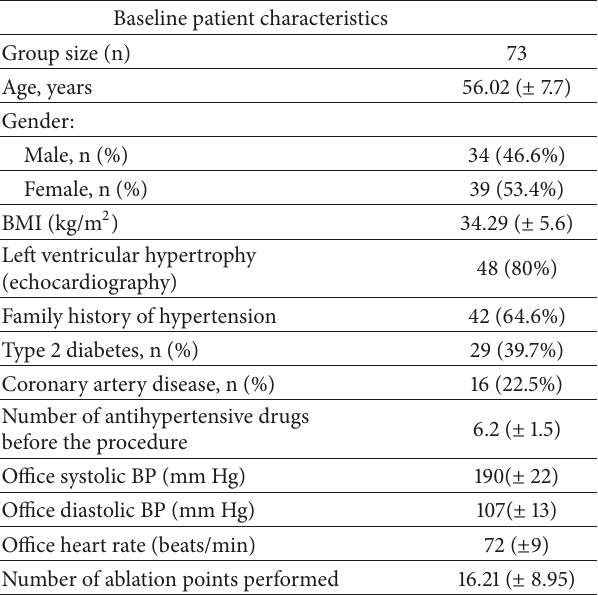
Table 1: Baseline patient